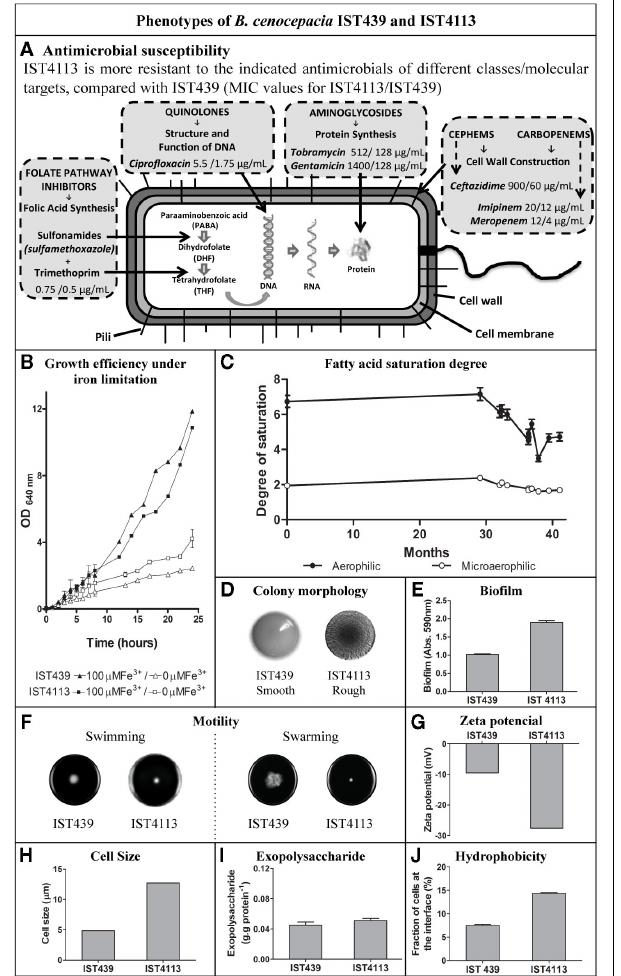
FIGURE 3 | Phenotypic characteristics of the B. cenocepacia clonal variants IST439 and IST4113, retrieved from the same CF patient sputum during long-term residence in the lung and whose genomic expression was compared by quantitative proteomic and transcriptomic analyses. (A) Minimum inhibitory concentration (MIC) values; (B) Growth of IST439 and IST4113 under limited or load iron conditions; (C) Fatty acid saturation of the clonal variants obtained during the 41-months of chronic colonization; (D) Colony morphology; (E) Amount of biofilms formed based on crystal violet method; (F) Swarming and swimming motilities; (G) Zeta potential; (H) Cell size; (I) Exopolysaccharide produced; (J) Fraction of cells at the interface of water and n -hexadecane. Based on results from Coutinho et al. (2011) and Madeira et al. (2011).